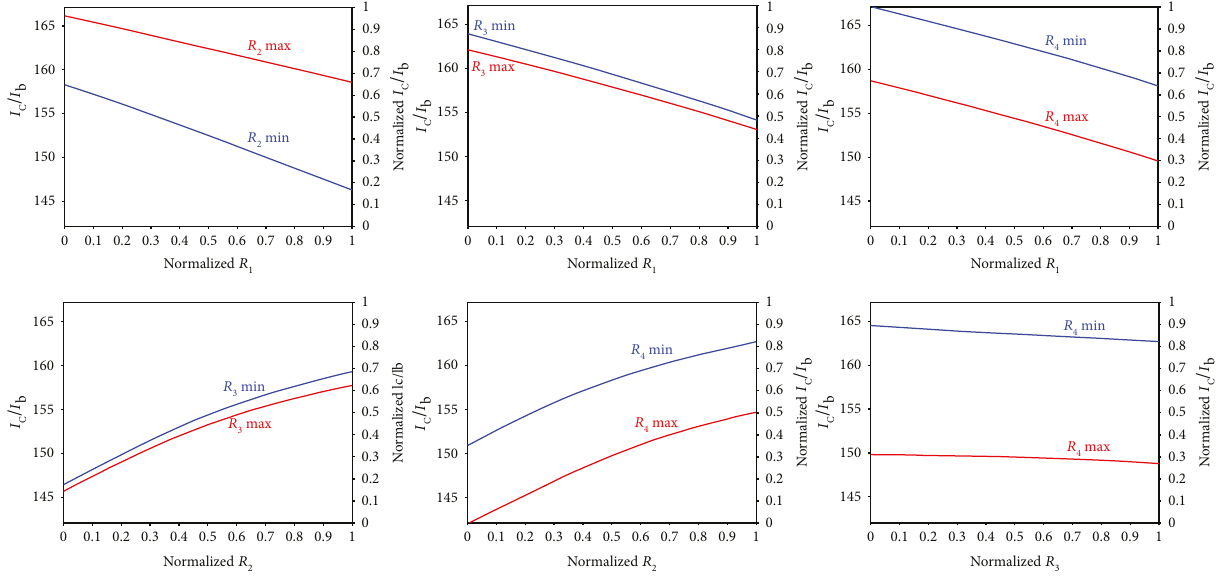
Figure 8: Interaction e ff ect plot showing the I